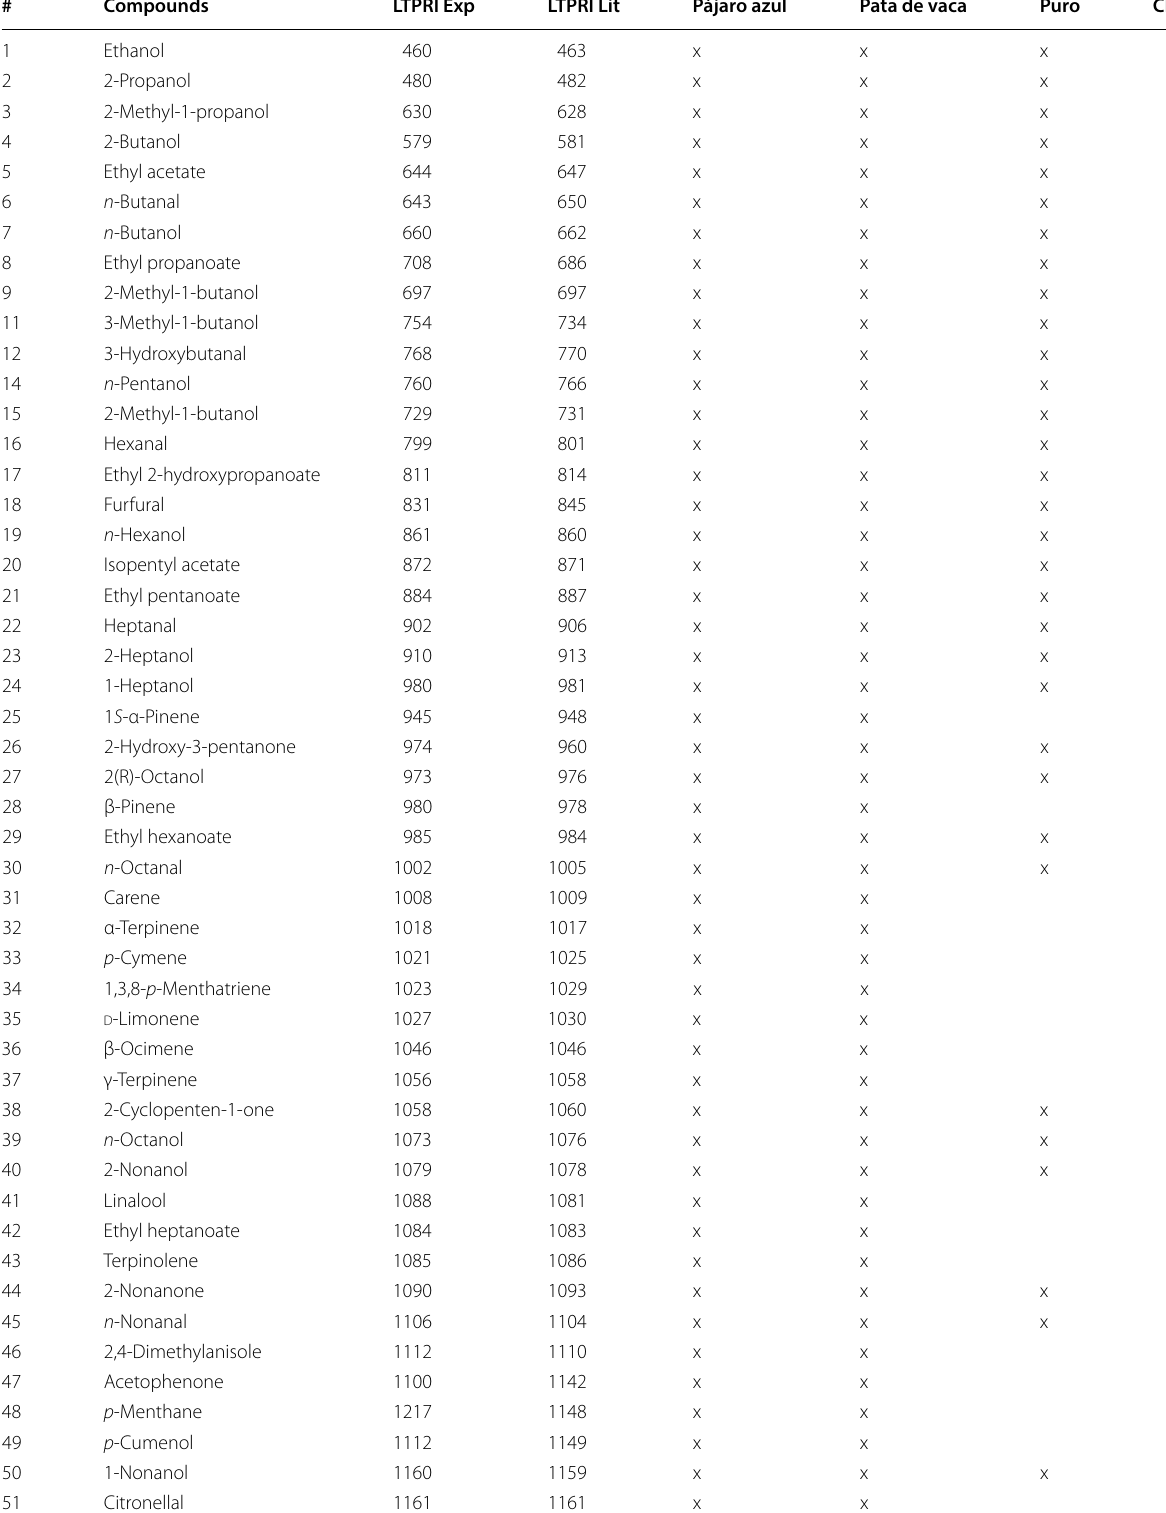
Table 1 Compounds identified in the Ecuadorian spirits beverages using GC